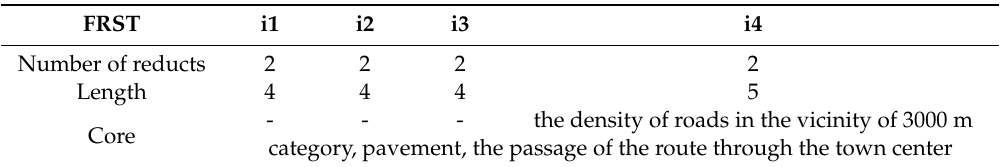
Table 9. Number, size, and cores of reducts designated using the FRST method for the selection of road sections to the scale of 1:50,000. FRST i1 i2 i3 i4 Number of reducts 2 2